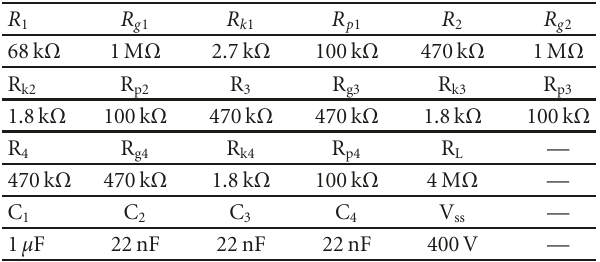
Table 1: Values for circuit elements for Figure